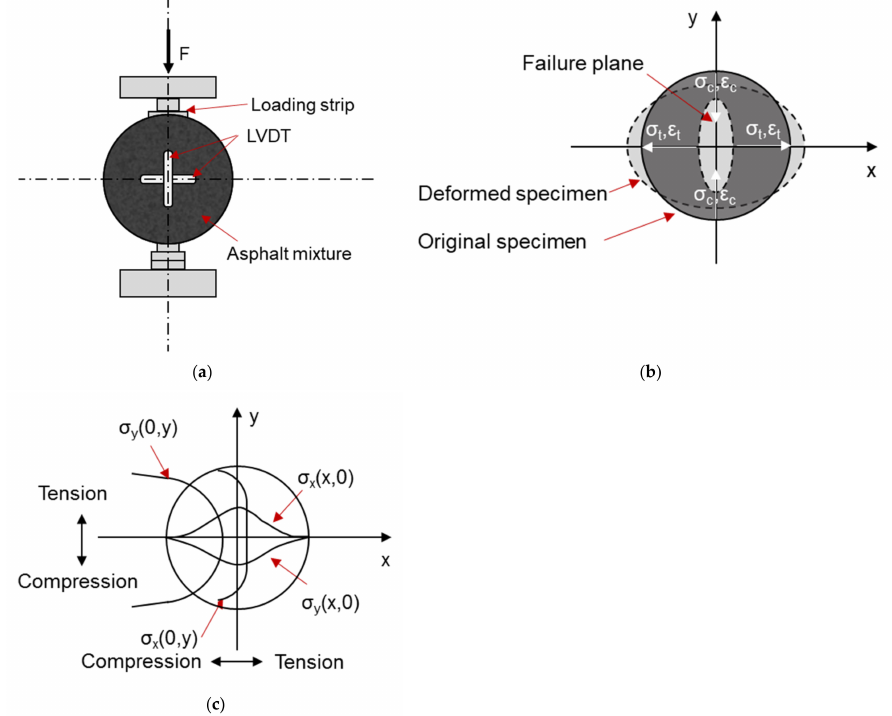
Figure 10. Schematic diagram and stress distribution of ITFT. ( a ) ITFT test setup. ( b ) Stress and strain on the diameters. ( c ) Stress distribution along horizontal and vertical